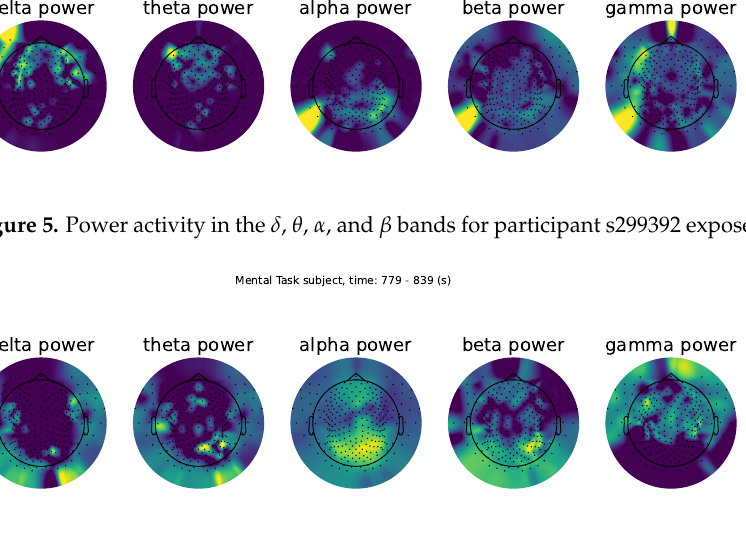
Figure 6. Power activity in the δ , θ , α , and β bands for participant s303840 exposed to the mental